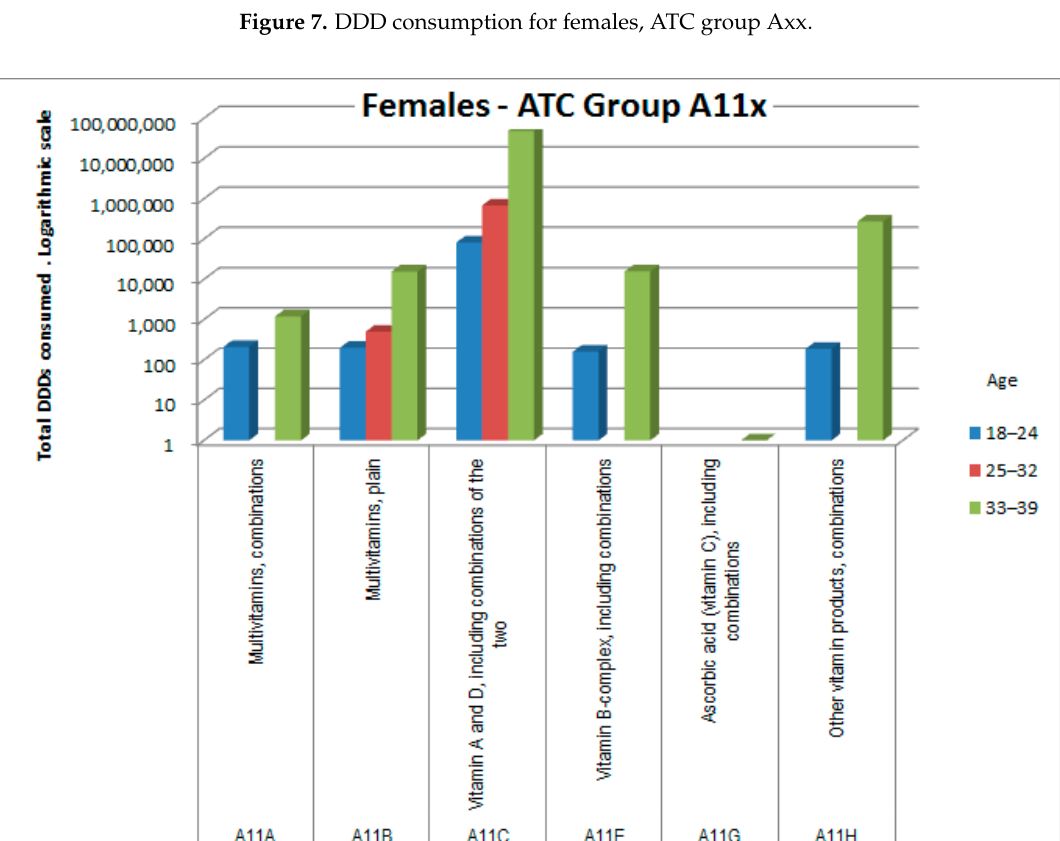
Figure 9. DDD consumption for females, ATC group Nxxx.